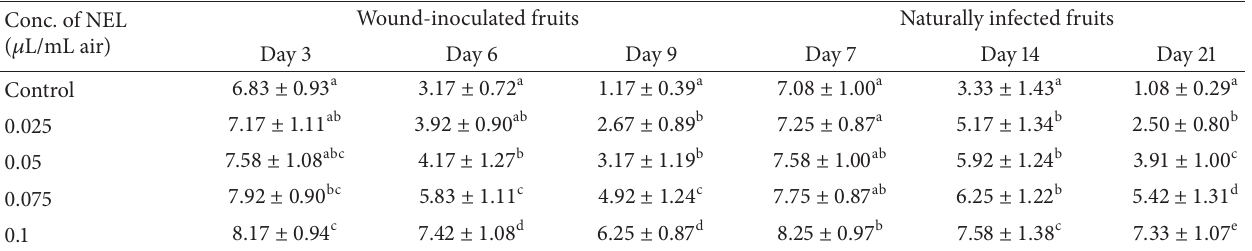
Conc.: Concentration. a ∼ e Values are mean ( 𝑛 = 3 ) ± standard deviations. Values followed by the same letter in each column are not significantly different in ANOVA and Duncan multiple range test ( 𝑃 < 0.05